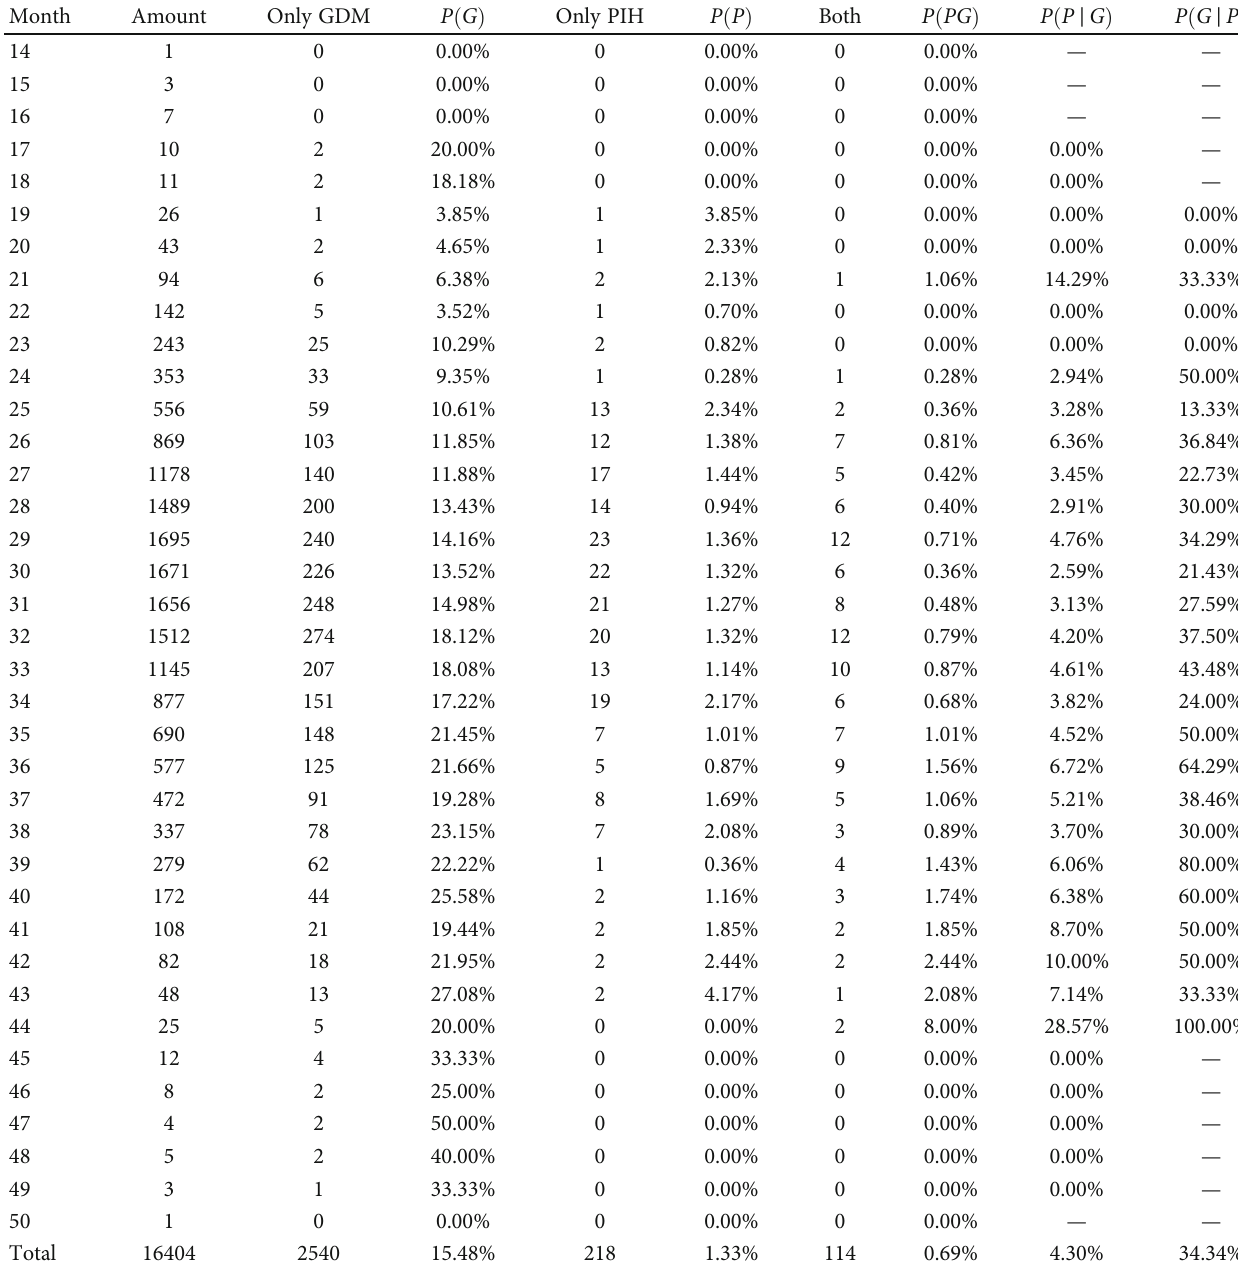
Table 2: Statistical results distributed by